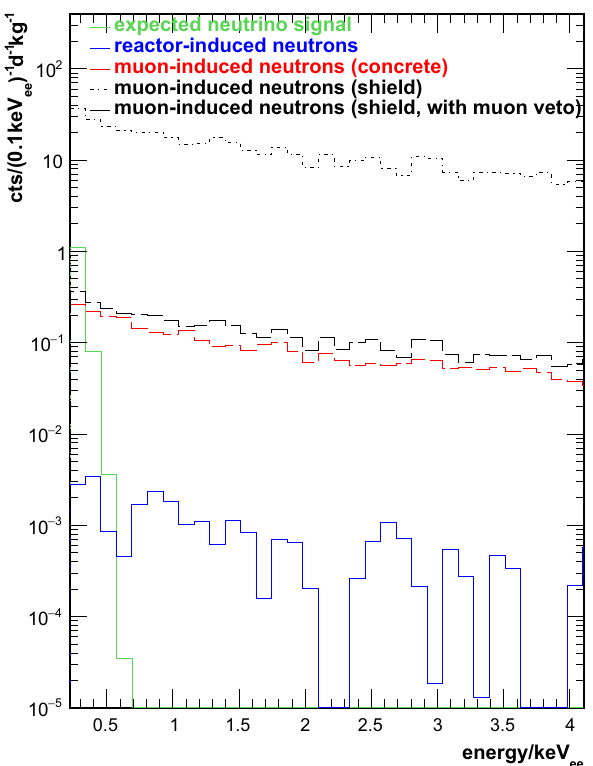
Fig. 27 Comparison of the reactor-correlated neutron spectrum at the HPGe (from MC) and the expected CE ν NS signal. The dashed line represents the steady-state muon-induced neutron contributions (from MC)fromneutronscreatedintheconcreteandinsidetheshield(reduced by the muon veto). The short dashed line corresponds to the muon- induced neutrons inside the shield without applied muon veto Comparing the integral ranges outside of the region of interest between reactor ON and OFF data for one month of reactor OFF data and six months of reactor ON data, the results are consistent with the findings here.